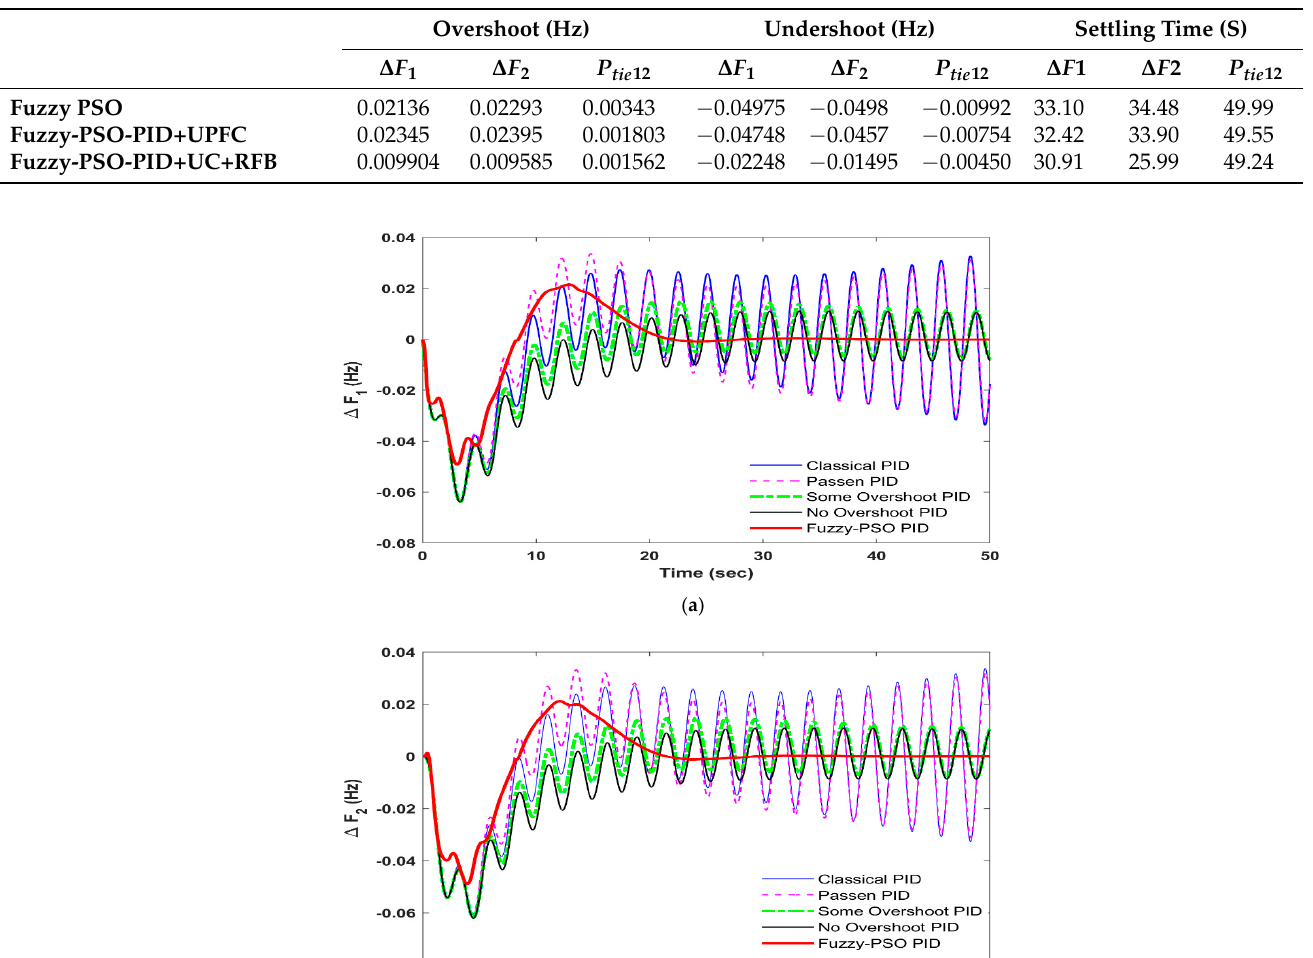
Table 4. Comparison performance overshoot, undershoot, and settling time shown in Figure 8a–c.